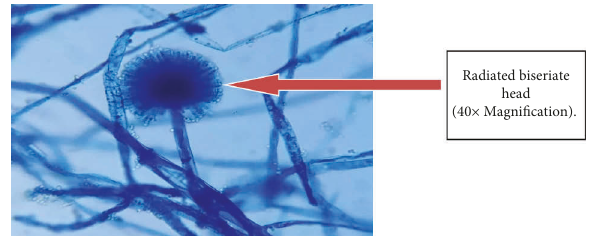
Figure 3: Aspergillus flavus showing structural radiated biseriate head in LPCB stain.